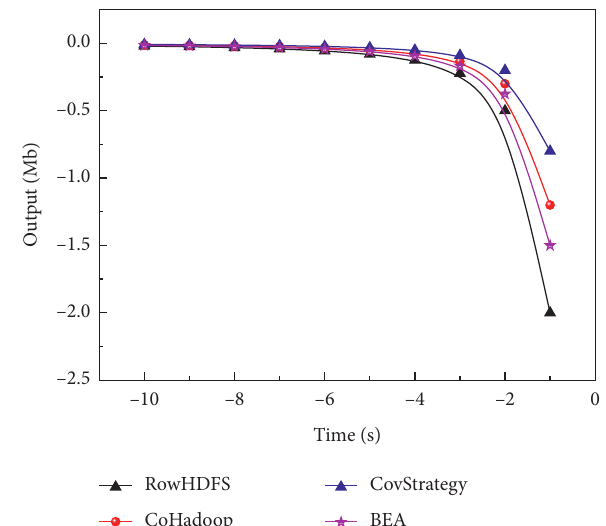
Figure 8: Comparison of query performance of two tables’ joins under different data